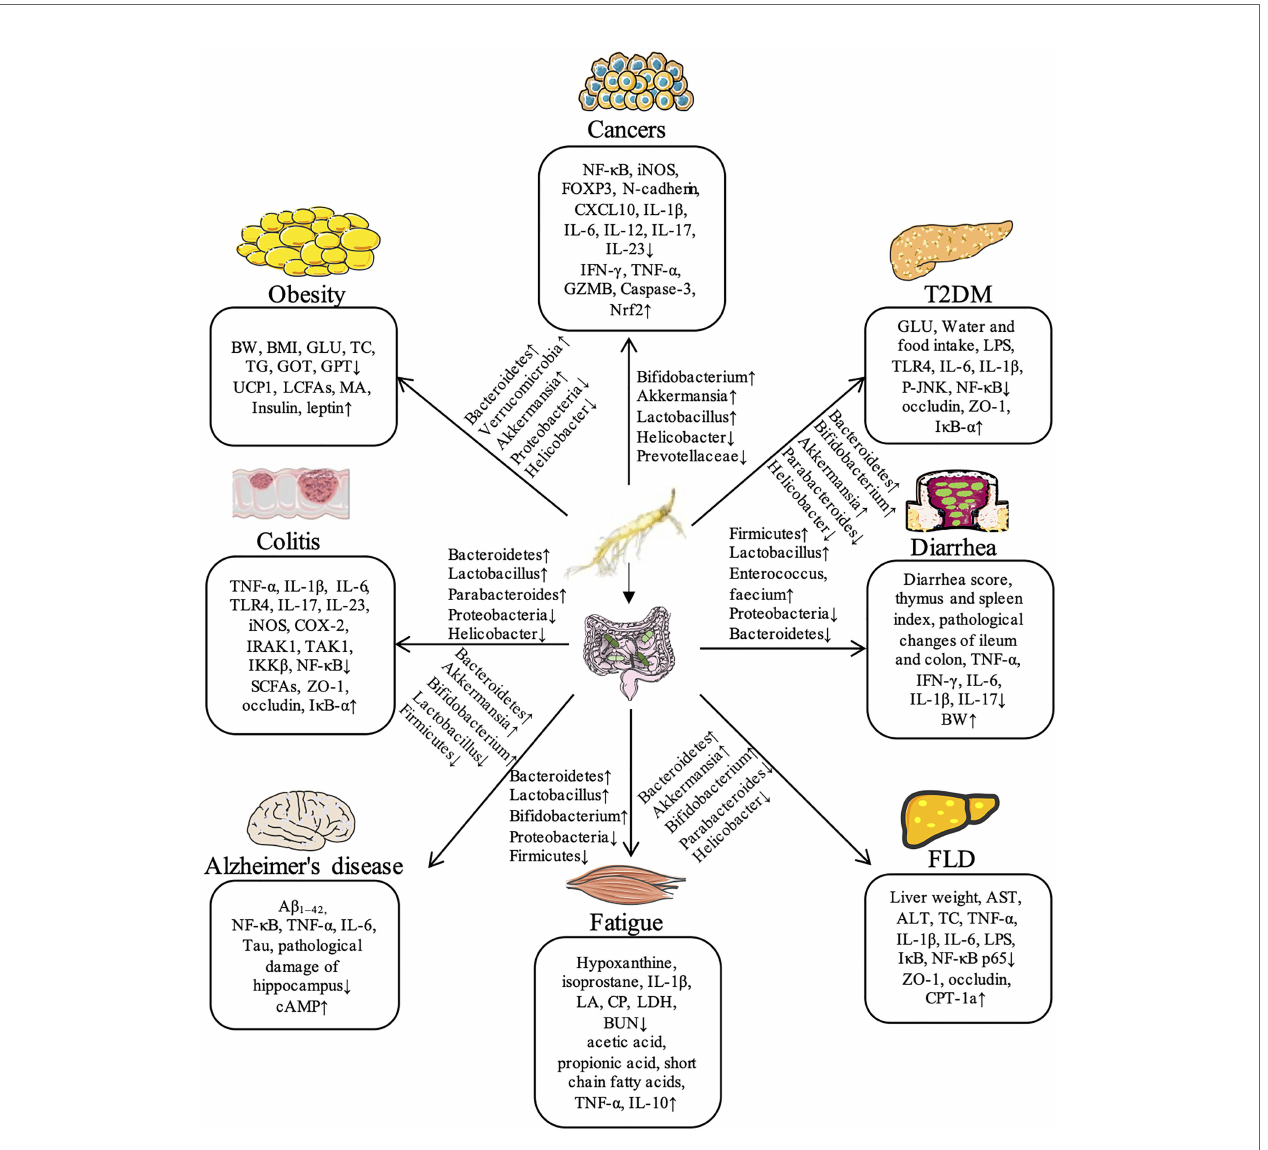
FIGURE 1 | Ginseng shows its potential therapeutic effects on a variety of diseases through the regulation of gut microbiota in animal